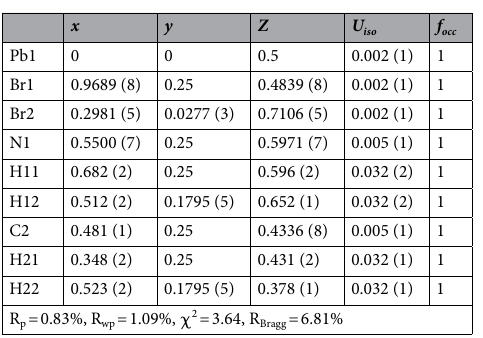
Table 3. Crystallographic data for MAPbBr 3 phase in orthorhombic system ( Pnma ) from NPD at 2 K. a = 7.9335(4) Å, b = 11.8301(5) Å, c = 8.5743(3) Å and V = 804.74(5) Å 3